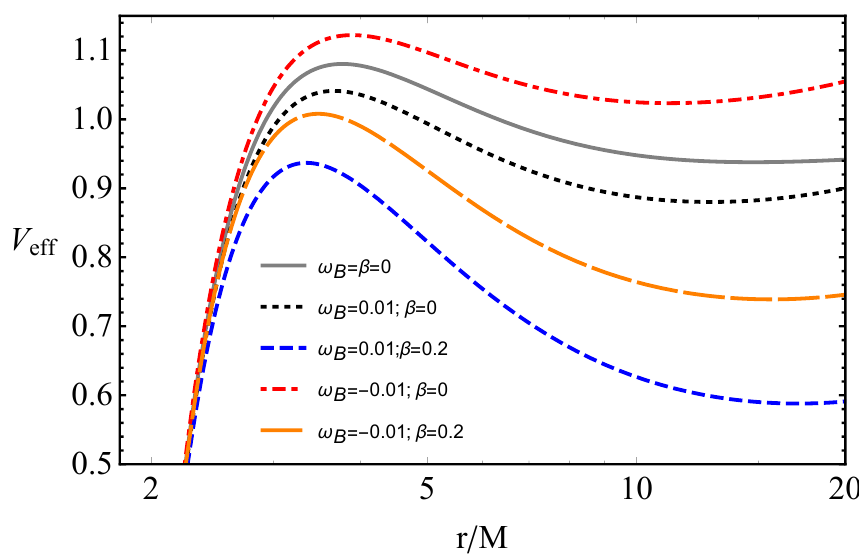
Figure 1. The radial dependence of the effective potential for magnetized and charged test